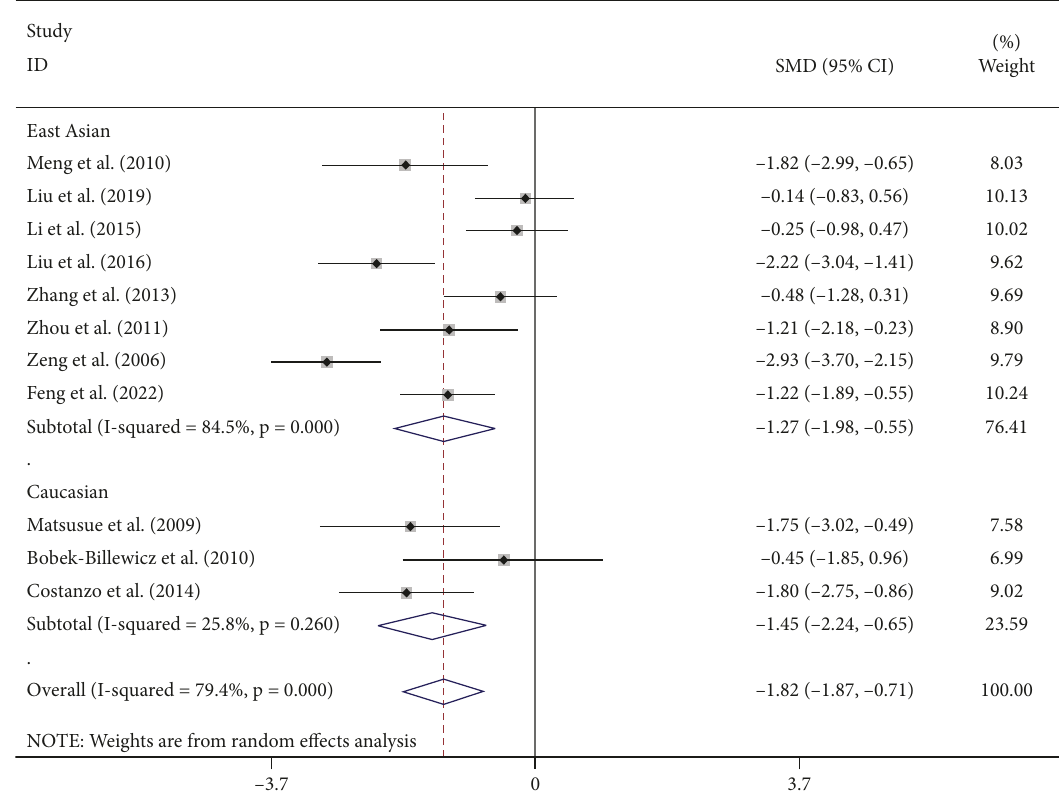
Figure 3: Forest plot of the rADC of the radiation injury group and the recurrent glioma group detected by DWI combined with MRS.